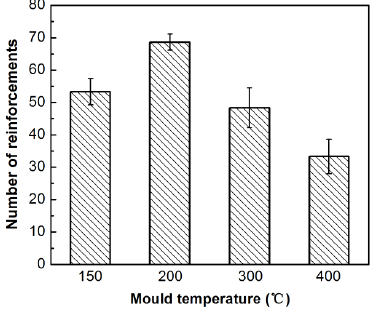
Figure 14. Visible reinforcement number on the fracture surfaces of the composites thixoformed at different mold temperatures.